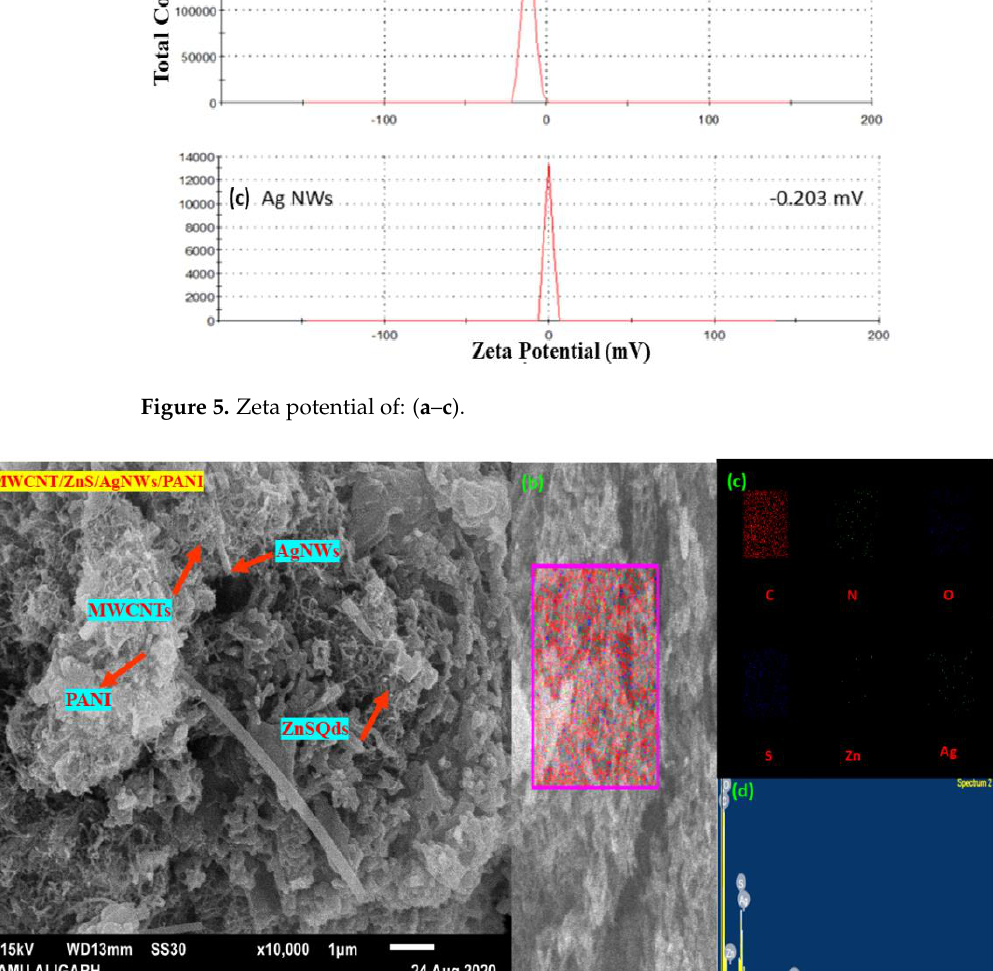
Figure 5. Zeta potential of: ( a – c ).